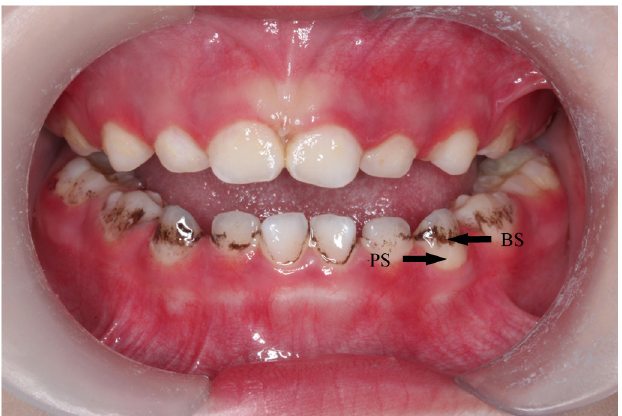
Fig 1. Primary dentition with more than six black-stained teeth. Black stain (BS) was found as dark pigmented lines or incomplete coalescence of dark dots on the cervical enamel following the contour of the gingiva. Samples of both black stain (BS) and dental plaque (PS) were collected from children with black stain.